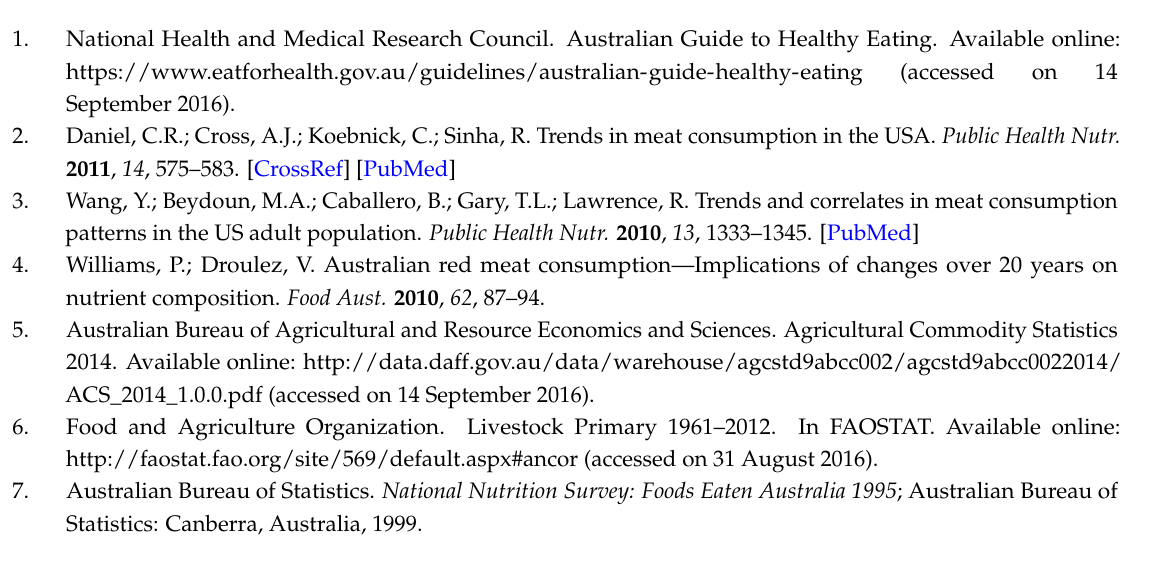
Table S1: Characteristics of the respondents from the National Nutrition Survey 1995 (NNS 1995) and the Australian National Nutrition and Physical Activity Survey 2011–2012 (NNPAS 2011–2012), Table S2: Categorization of meat/poultry/fish, Table S3: Per-capita mean consumption (g) of meat/poultry/fish from 1995 to 2011–2012, Table S4: Per-consumer consumption (g) of meat/poultry/fish from 1995 to 2011–2012. Acknowledgments: Australian Bureau of Statistics for the 2011–2012